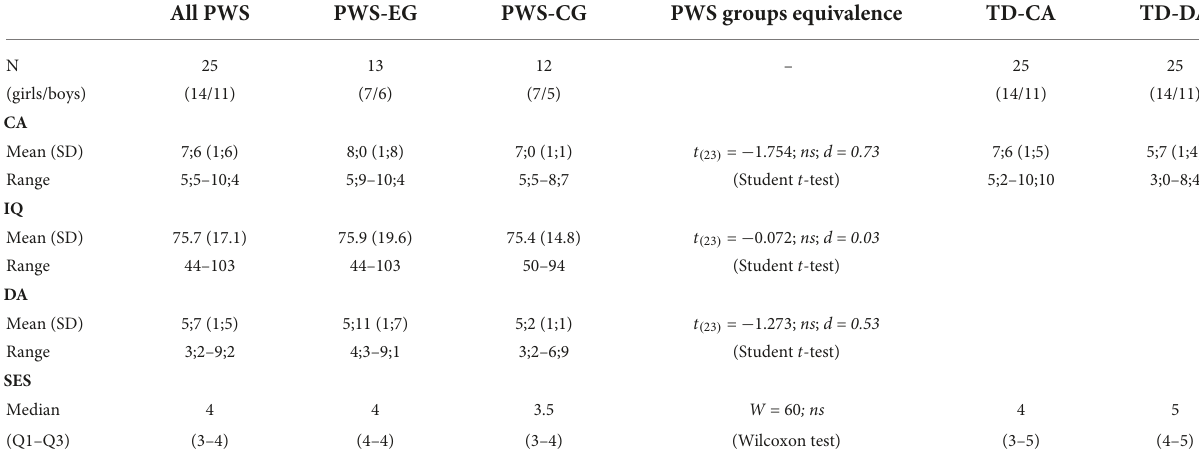
TABLE 1 Descriptive characteristics for PWS and TD